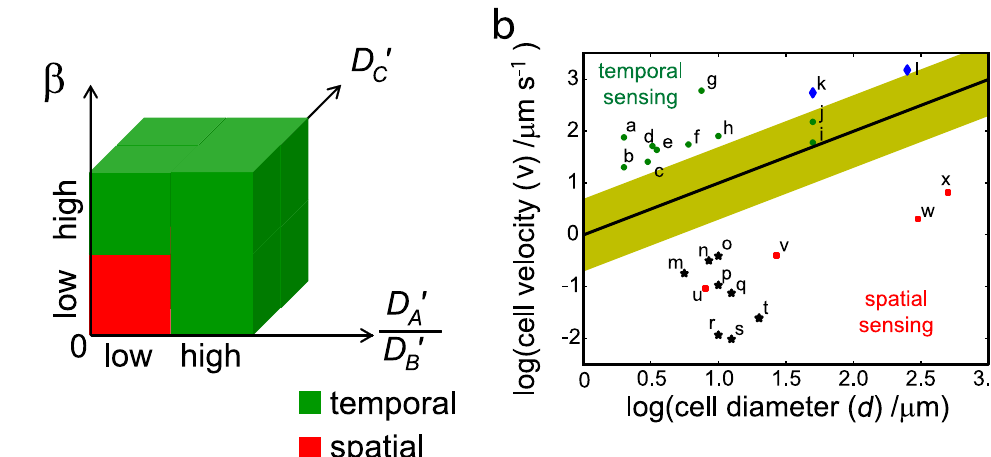
Fig 5. Choice of temporal versus spatial sensing. (a) Parameter space for choice of temporal versus spatial sensing. (b) Plot of log (cell diameter, d ) versus log(cell velocity, v ) for chemotactic cells. The respective cells are as follows; In the flagellar group (green dots) are a: Vibriocholarae , b: Escherichia coli , c: Helicobacter pylori , d: Pseudomonas aeruginosa , e: Salmonella typhimurium , f: Marine Vibrioid bacteria sampled from Niva Bay, g: Thiovulum majus , h: Chlamydomonas reinhardtii , i: Sperm (human) and j: Sperm (Sea urchin). In the cilia group (blue diamonds) are k: Tetrahymena thermophila and l: Paramecium . In the lamellipodia/ filopodia group (black stars) are m: T cell, n: Neutrophil, o: Hemocyte, p: B cell, q: Dendritic cell, r: Endothelial cell, s: Fibroblast and t: Border cells. In the pseudpodia group (red squares) are u: Dictyostelium discoideum , v: Acanthamoeba castellanii , w: Amoeba proteus and x: Chaos carolinensis . Assuming a signaling rate, l BC , occurring between 0.2 s −1 to 5 s −1 then the yellow region will be the separating boundary between cells with high and low values of β . The black line is the decision boundary for l BC = 1 s − 1